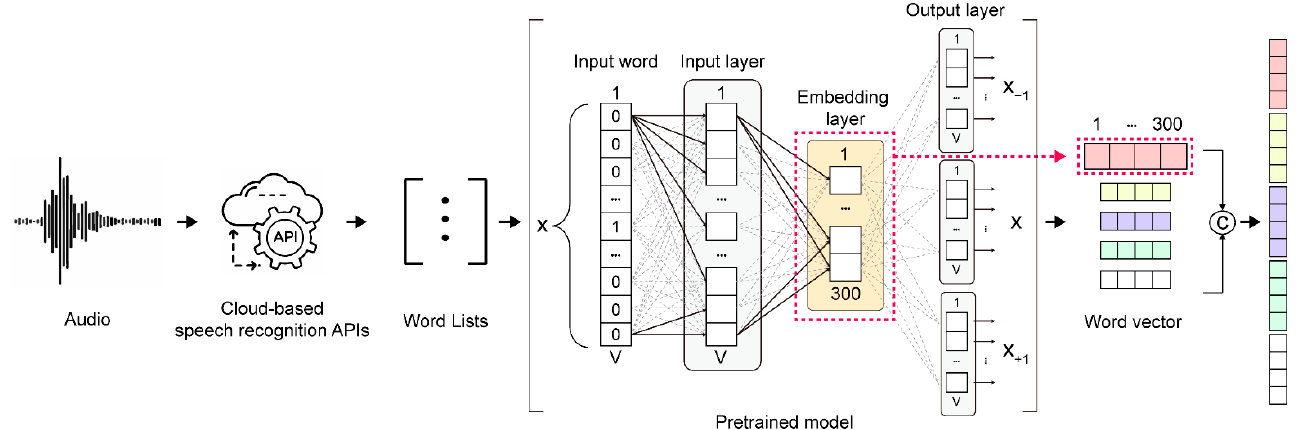
Figure 2. Block diagram of the proposed audio speech recognition module.